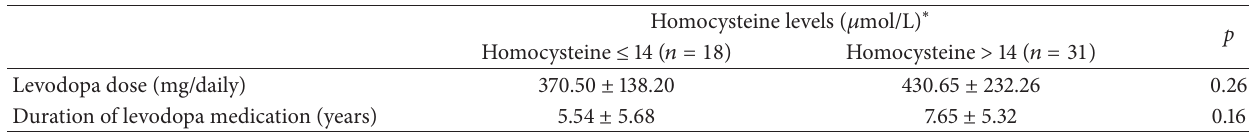
Table 4: Comparison of daily levodopa dose and duration of levodopa medication between patients with plasma homocysteine levels ≤ 14 and > 14 𝜇